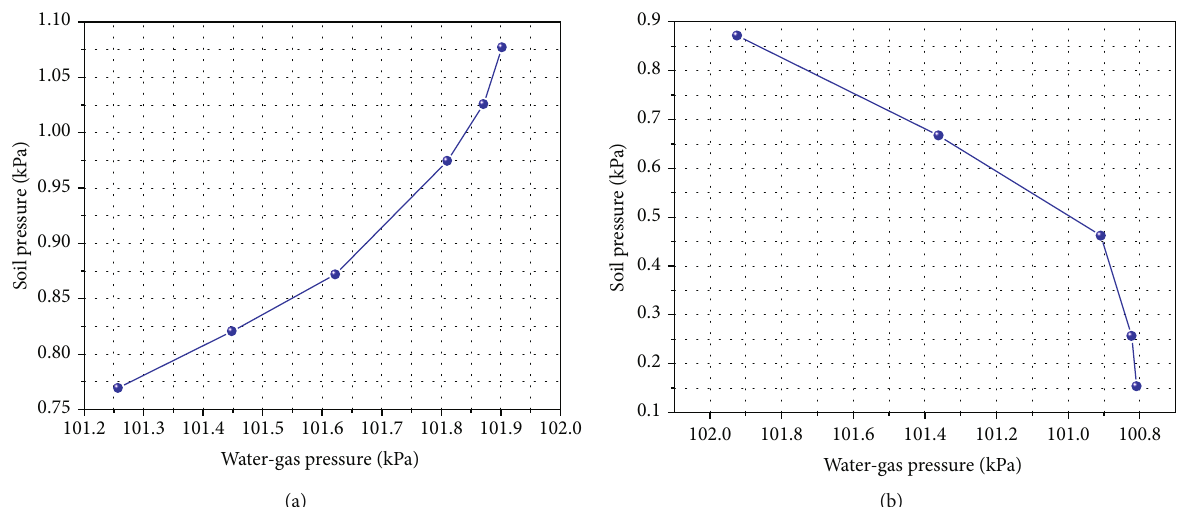
Figure 8: The relationship between soil pressure and water-gas pressure. (a) Water level rise. (b) Water level